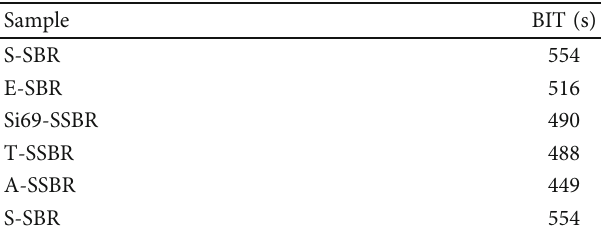
Figure 4: The di ff erence between the initial and fi nal torques of the mixtures. Table 4: Filler mixing time (BIT) for the di ff erent mixtures.